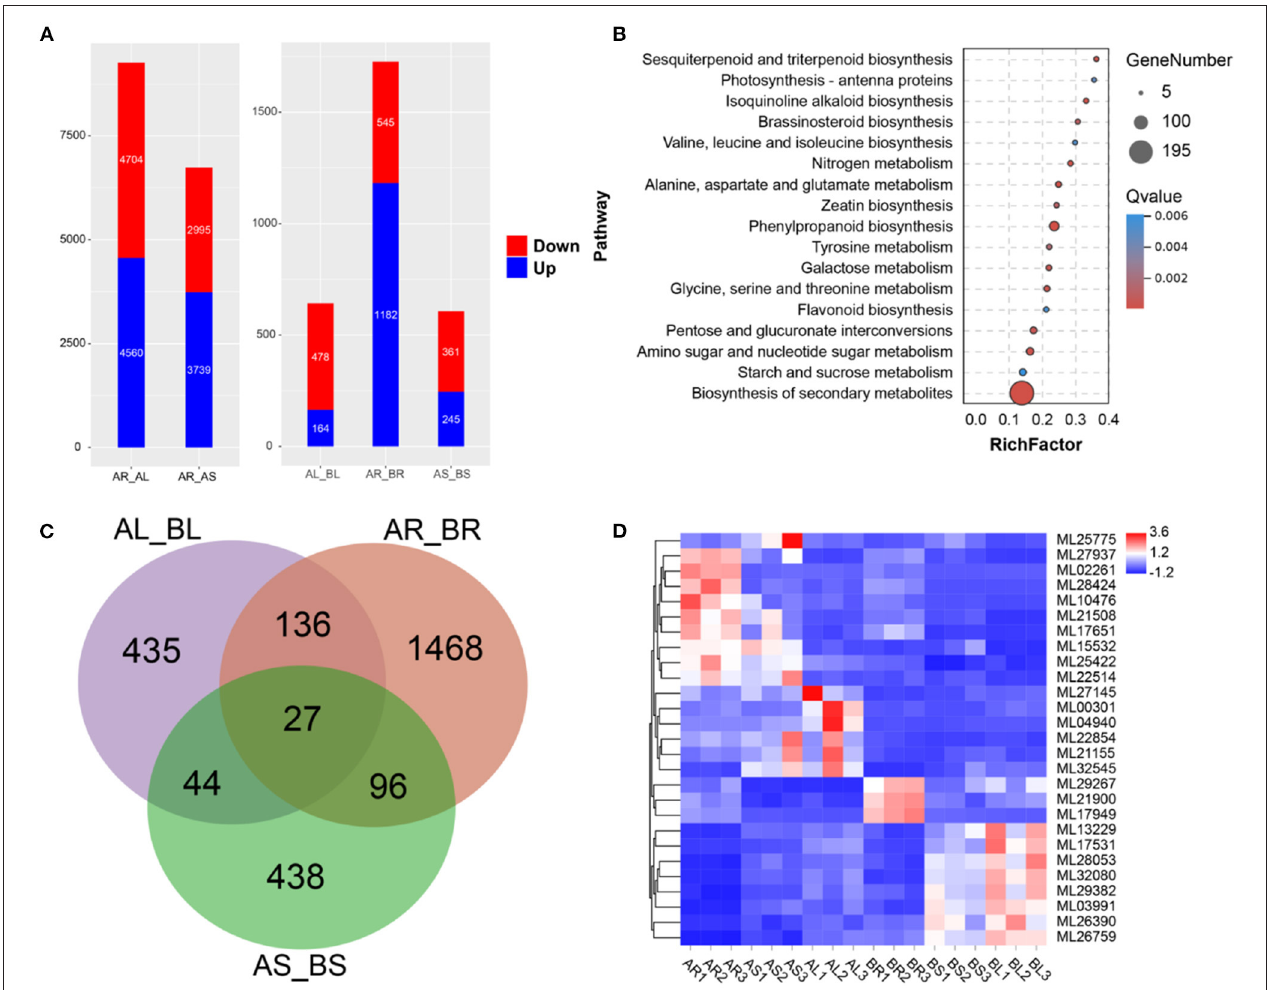
FIGURE 4 | Transcriptome analysis. (A) Differentially expressed genes (DEGs) between the leaves, stems, and roots. AR_AL: DEGs in leaves relative to roots; AR_AS: DEGs in stems relative to roots; AL_BL: DEGs in leaves of treated sample relative to control sample. AR_BR: DEGs in roots of treated sample relative to control sample. AS_BS: DEGs in stems of treated sample relative to control sample; (B) Kyoto Encyclopedia of Genes and Genomes (KEGG) enrichment analysis of DEGs in treated samples relative to control samples. (C) Venn diagram of DEGs; (D) Expression of 27 DEGs in the leaves, stems, and